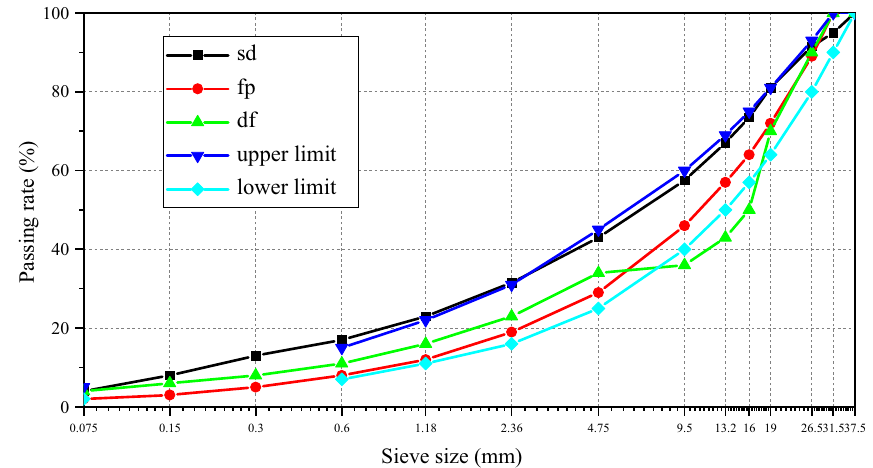
Figure 3. Gradation curves of lime and fly ash-stabilized macadam.